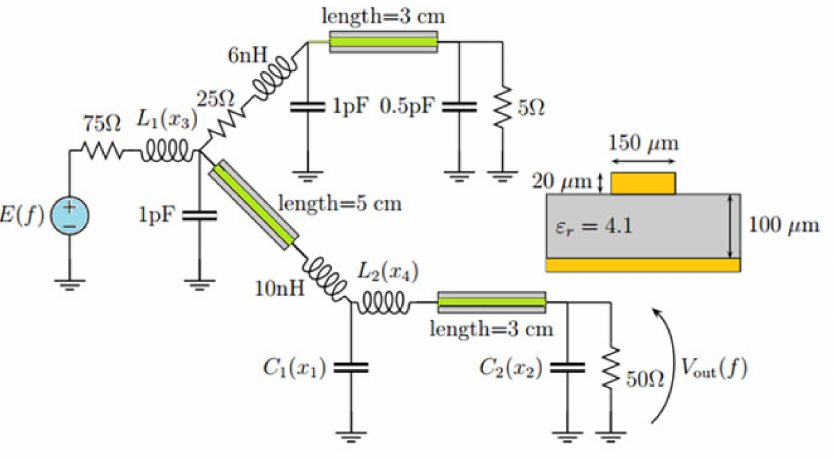
Figure 5. Schematic of the high-speed interconnect